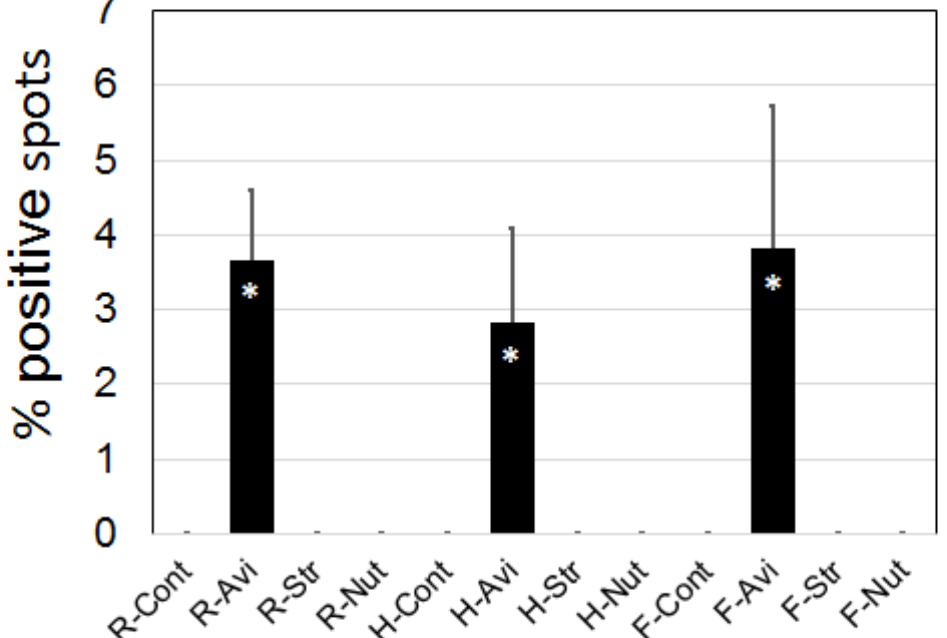
Figure 3. Avidin visible fluorescent spots. Positive spots were counted as a proportion of sperm seen with visible light. Asterisk indicates a significant difference p < 0.001. Abbreviations: R = room temperature; H = Heated; F = Snap-frozen; Cont = control; Avi = Avidin; Str = Streptavidin; Nut = NeutrAvidin.